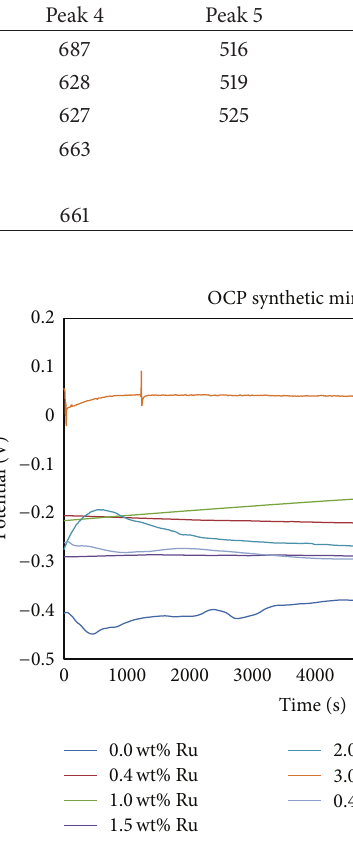
Table 4: Peak positions found on the surface of WC-Co-Ru/VC alloys after exposure in 1M sodium chloride solution. Sample (wt% Ru)